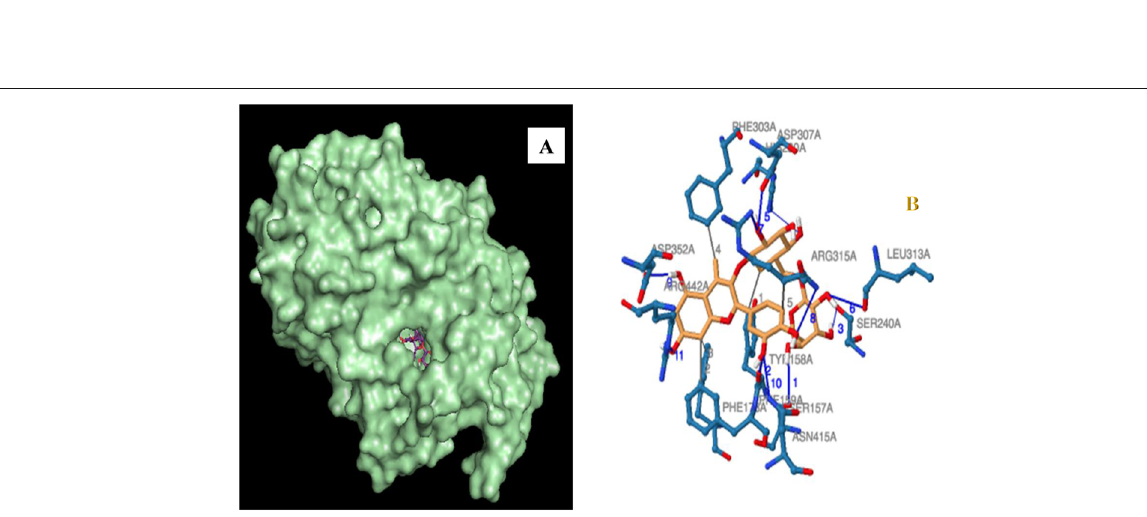
Fig. 6 Binding pose and binding site of rutin with α -glucosidase (panel A), molecular interaction of rutin with amino acid residues within the binding pocket of the protein structure (panel B)